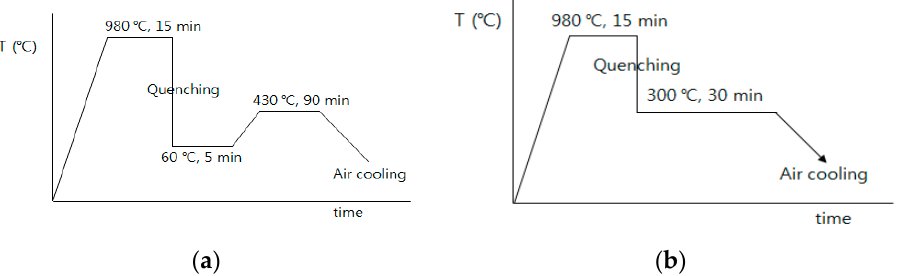
Figure 1. Heat treatment cycles used in this study. ( a ) quench and tempered (QT) cycle and ( b ) austempered (AT) cycle.